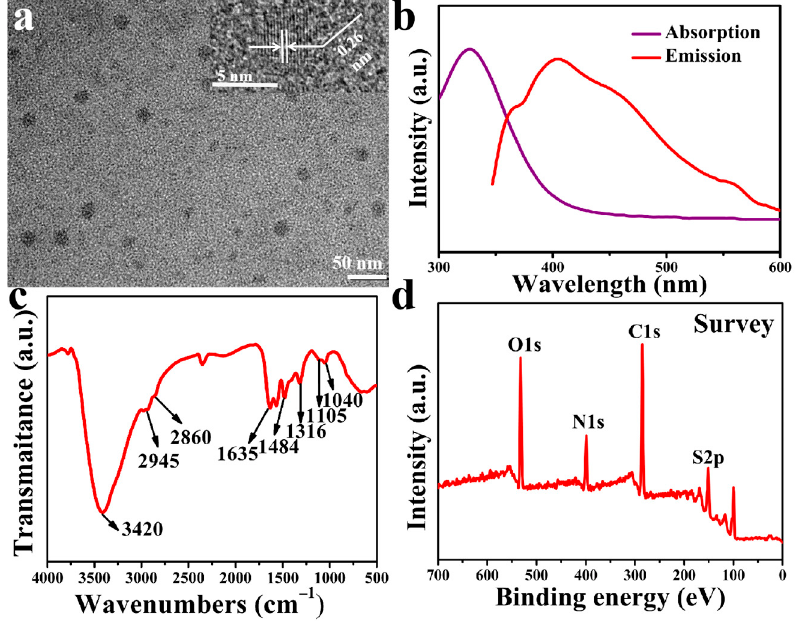
Figure 1 . ( a ) TEM image and HRTEM images of CDs; ( b ) the absorption spectrum and the fluorescence spectrum of CDs; ( c ) FTIR spectrum of CDs; ( d ) full-range XPS survey spectrum of CDs.